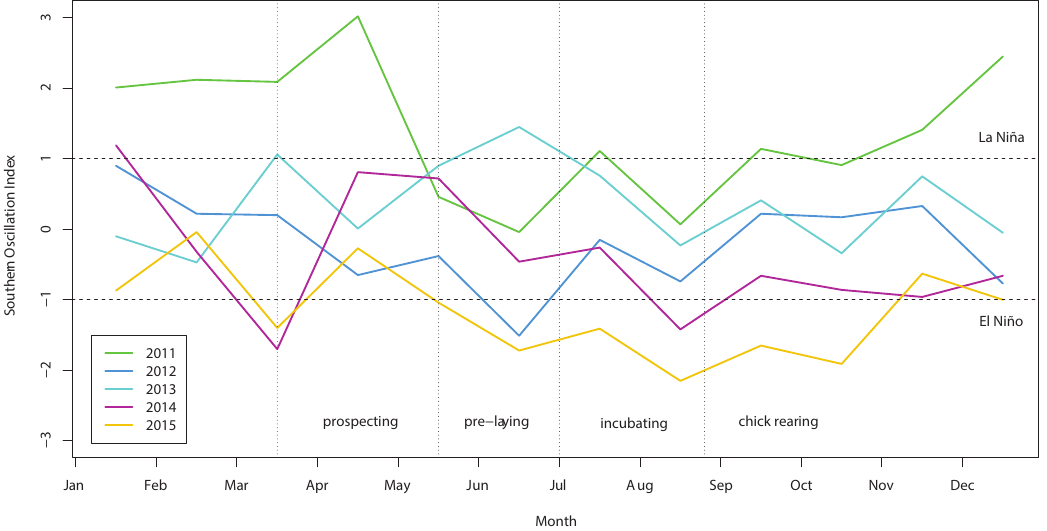
Figure 2. Monthly Southern Oscillation Index from 2011 to 2015. Horizontal bars indicate thresholds for declaring La Niña and El Niño events. Vertical bars indicate breeding stages for Grey-faced